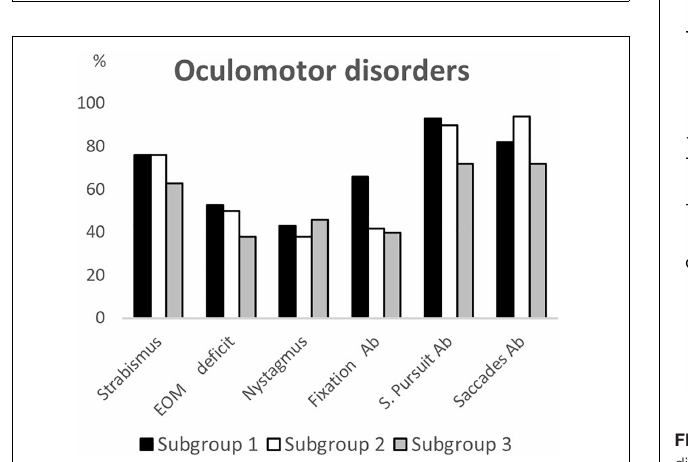
FIGURE 1 | Ophthalmological disorders according to age subgroups. A. Segment Ab, Anterior Segment abnormalities; Fundus Oculi Ab, Fundus Oculi abnormalities.